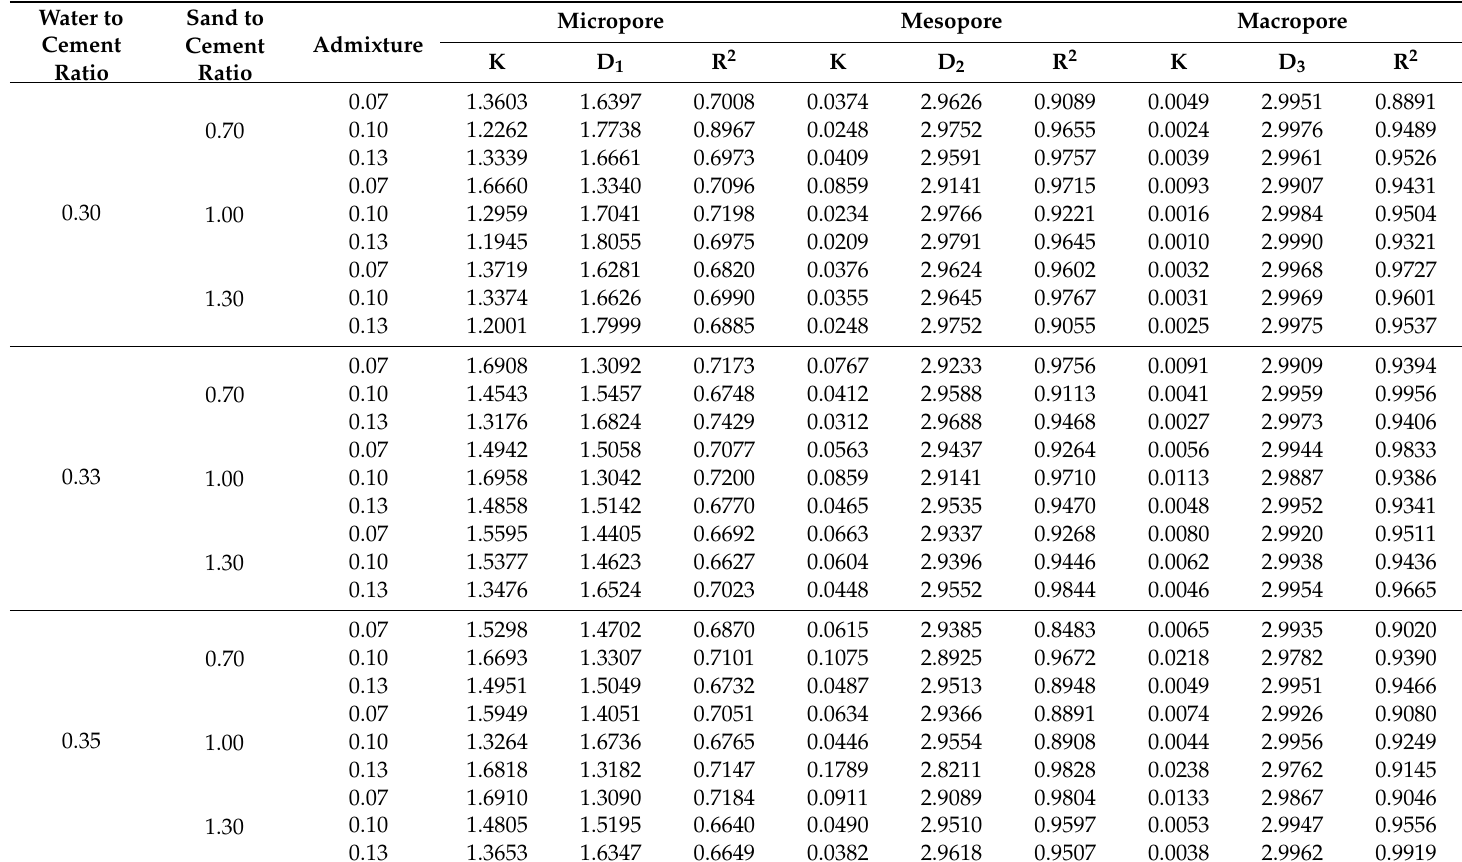
Table 5. Sample size fractal dimension